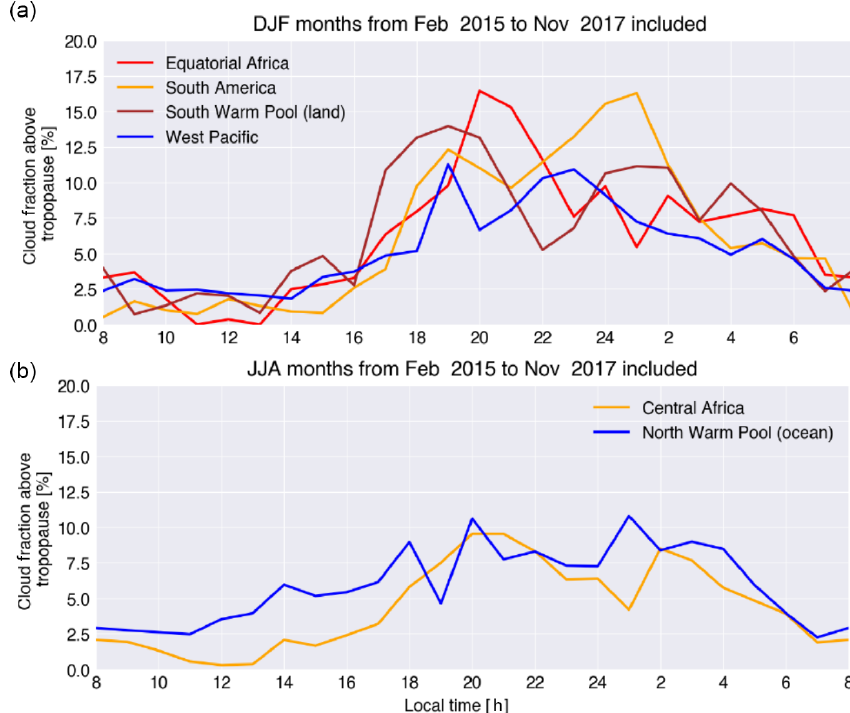
Figure 2. Diurnal cycle of stratospheric cloud fraction, by tropical region as in Fig. 1, averaged over DJF (a) and JJA (b)